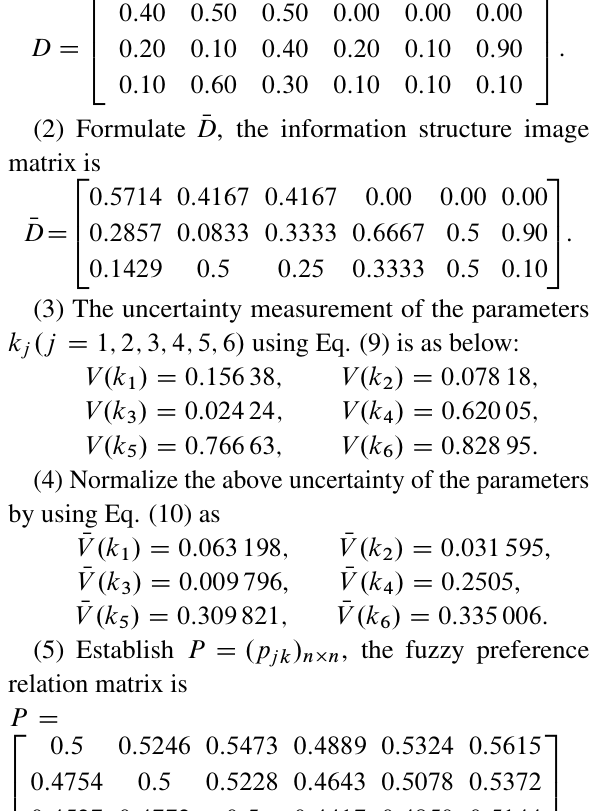
Table 8 BPA of x i with respect to k j .